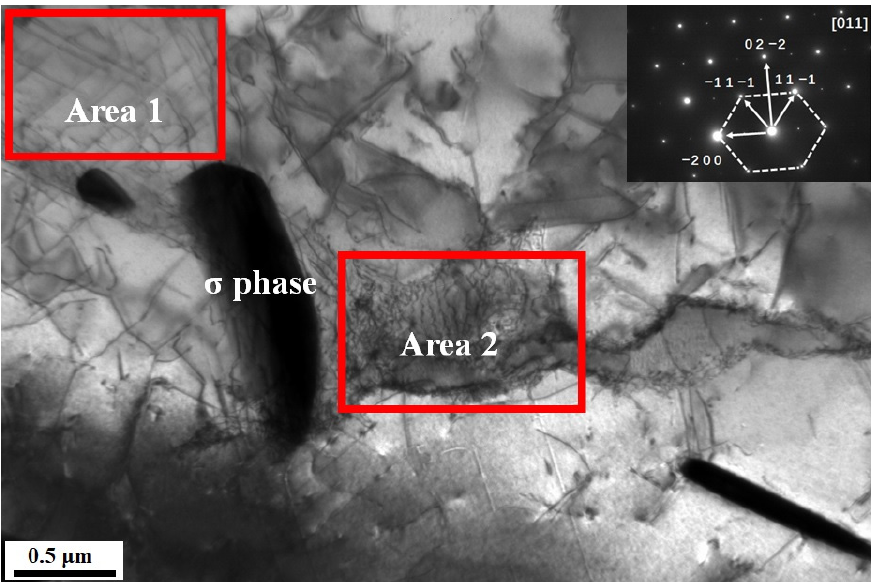
Figure 6. Bright field TEM image and diffraction pattern of the region with the beam from the [0 1 1] direction, which is 10 mm away from the fracture surface.